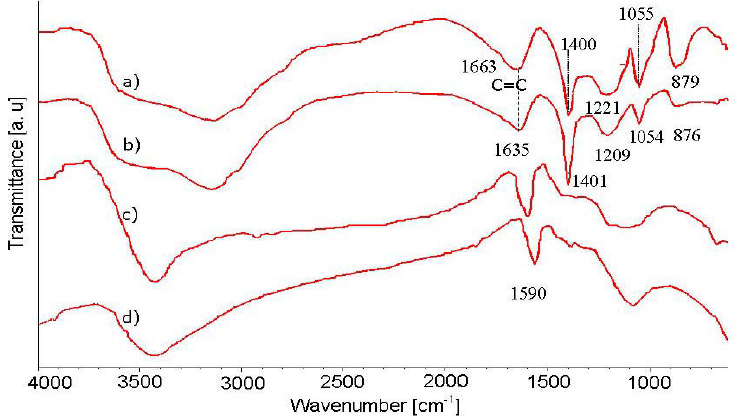
Figure 3. FTIR spectra images of SWNTs and PPy/SWNTs nanocomposites: ( a ) PPy; ( b ) PPy /SWNTs nanocomposite; ( c ) AP-grade SWNTs and ( d ) purified SWNTs.